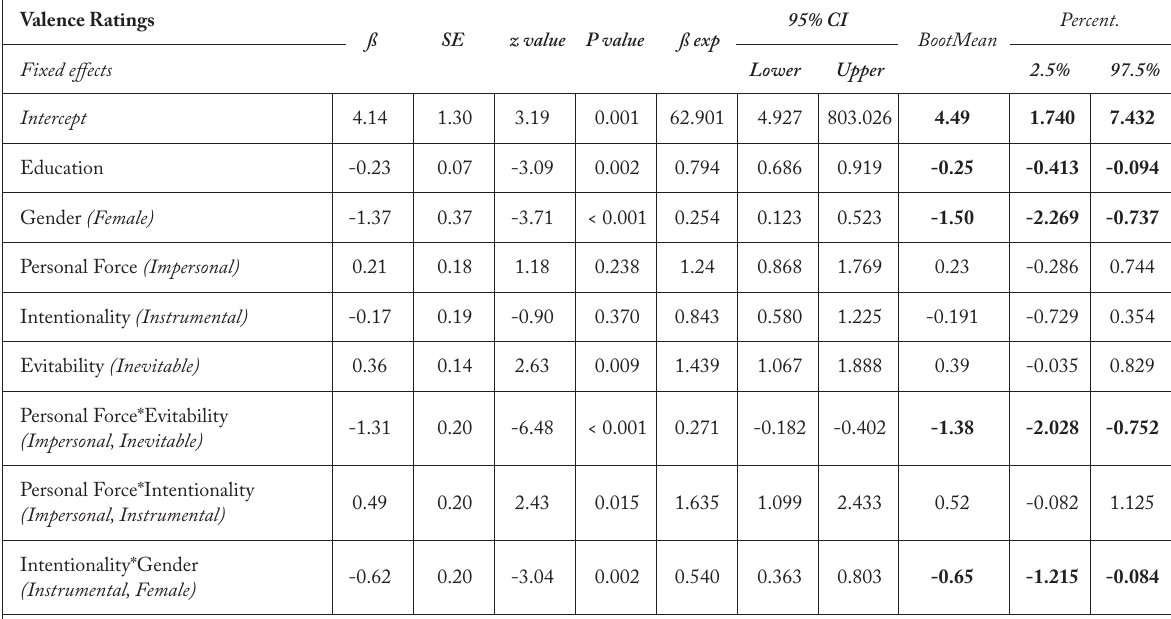
Table 4. Summary of the best linear mixed effects models on valence ratings for Study 2. Shorter ß values indicate less pleasant ratings.